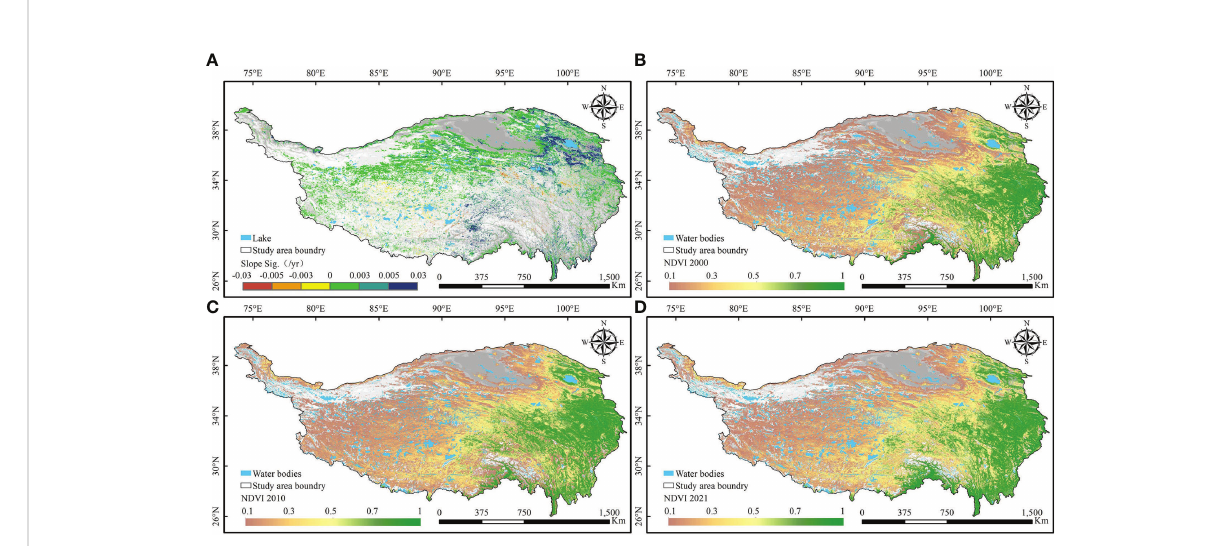
FIGURE 4 Spatial distribution of vegetation greenness changes on the Qinghai-Tibetan Plateau. (A) Signi fi cant trends of vegetation greenness. NDVI of the Qinghai-Tibetan Plateau in (B) 2000, (C) 2010 and (D) 2020.